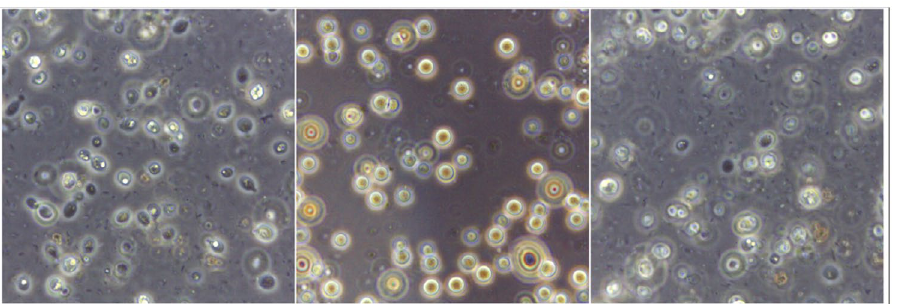
Fig. 4. ((A) Reference strain ) Papiliotrema laurentii (MTCC 2898), (B, C) Papiliotrema laurentii , (D, E, F) Naganishia albida .